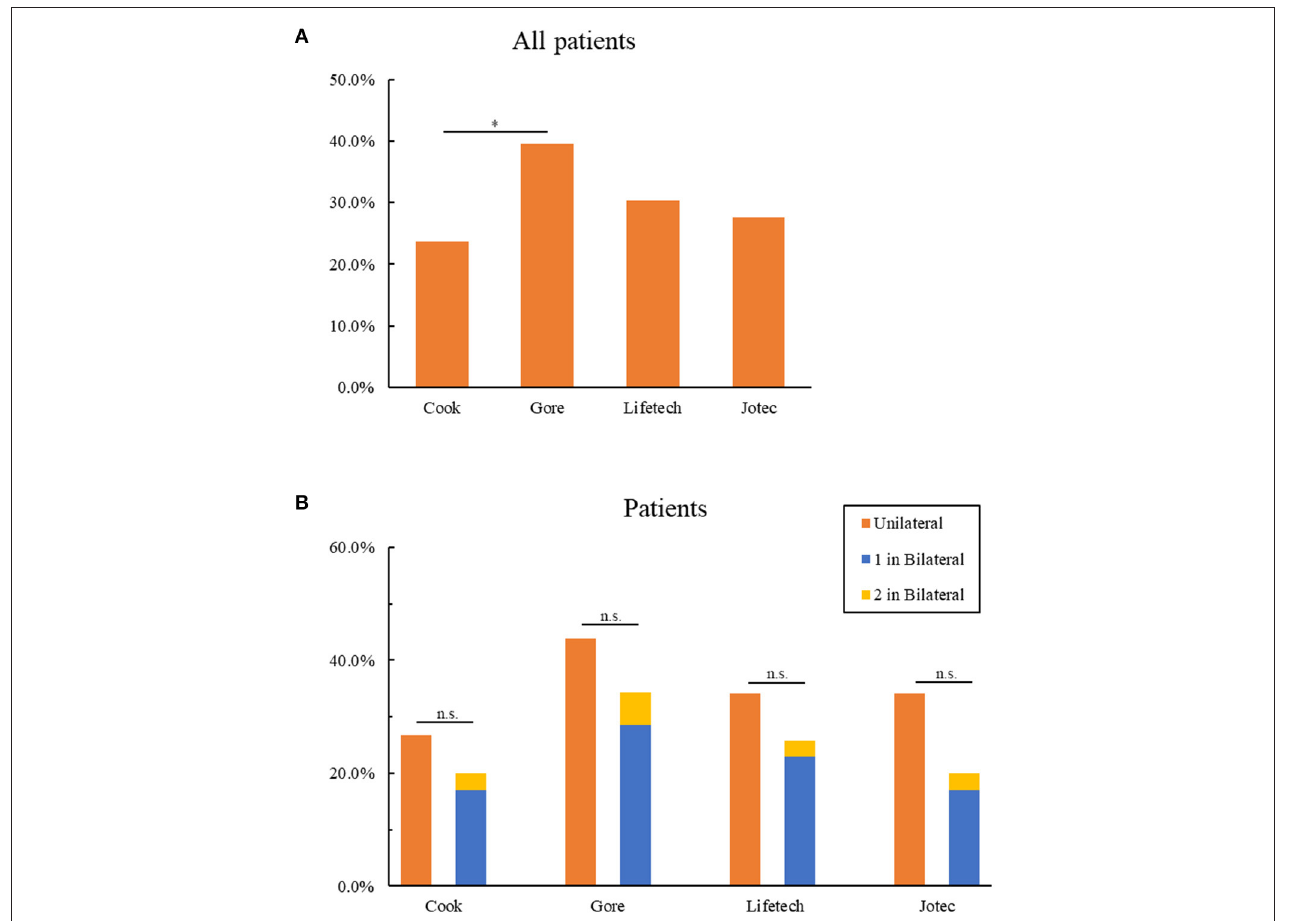
FIGURE 2 | Anatomic suitability of patients for IBDs. (A) Exclusion of all patients for four IBDs. (B) Comparison of the exclusion of patients with unilateral and bilateral lesions for four IBDs. 1 in bilateral represent patients with bilateral lesions who could be only treated one side by IBDs; 2 in bilateral represent patients with bilateral lesions who could be treated both sides by IBDs * P < 0.05; n.s. P > 0.05 (no significance); as determined by Chi-square test. IBD, iliac branch